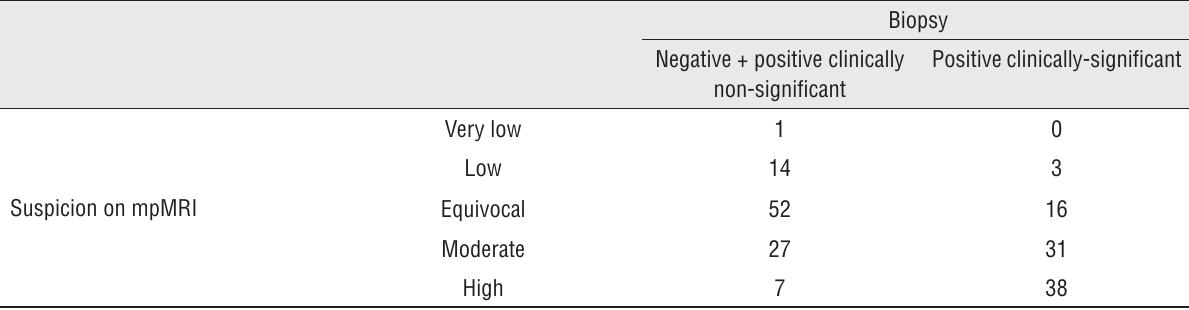
Table 3 - Suspicion level on mpMRI and biopsy results according clinical relevance.